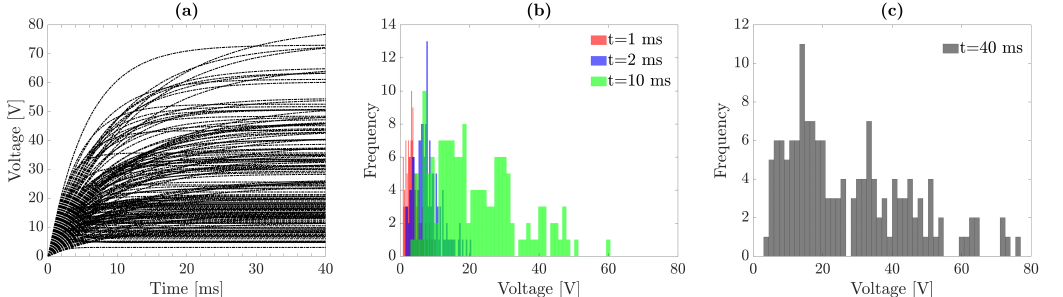
Figure 10. ( a ) Time evolution of v C after performing a Monte Carlo simulation at each time step. ( b ) Distribution of the values of v C at t = 1 ms, t = 2 ms, and t = 10 ms. ( c ) Distribution of the values of v C when the steady state is reached ( t = 40